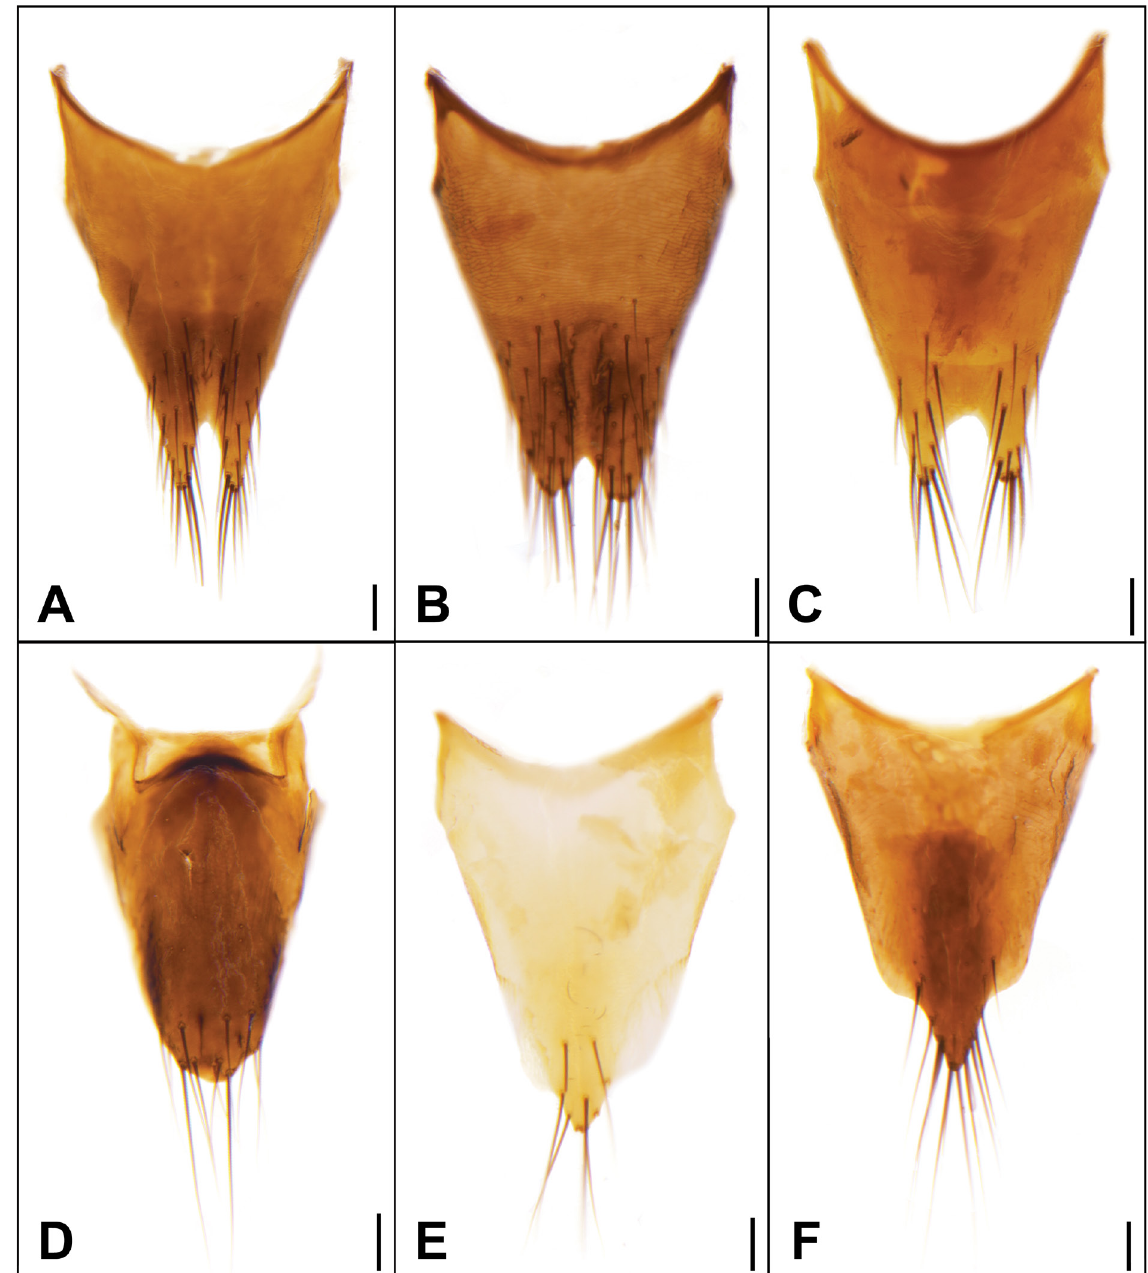
Fig. 7. Female tergite X. A . Indoquedius dispersepunctatus (Scheerpeltz, 1965). B . I. parallelicollis (Scheerpeltz, 1965). C . I. recticollis (Scheerpeltz, 1965). D . Malaisdius ruficeps (Scheerpeltz, 1965). E . Quedius ( Microsaurus ) rutilipennis Scheerpeltz, 1965. F . Q. ( M. ) impressithorax Scheerpeltz, 1965. Scale bars = 0.1